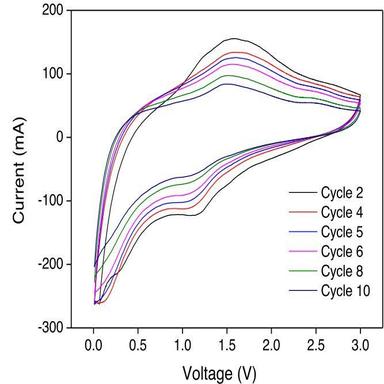
Cyclic voltammogram of MoO3 nanoparticles.